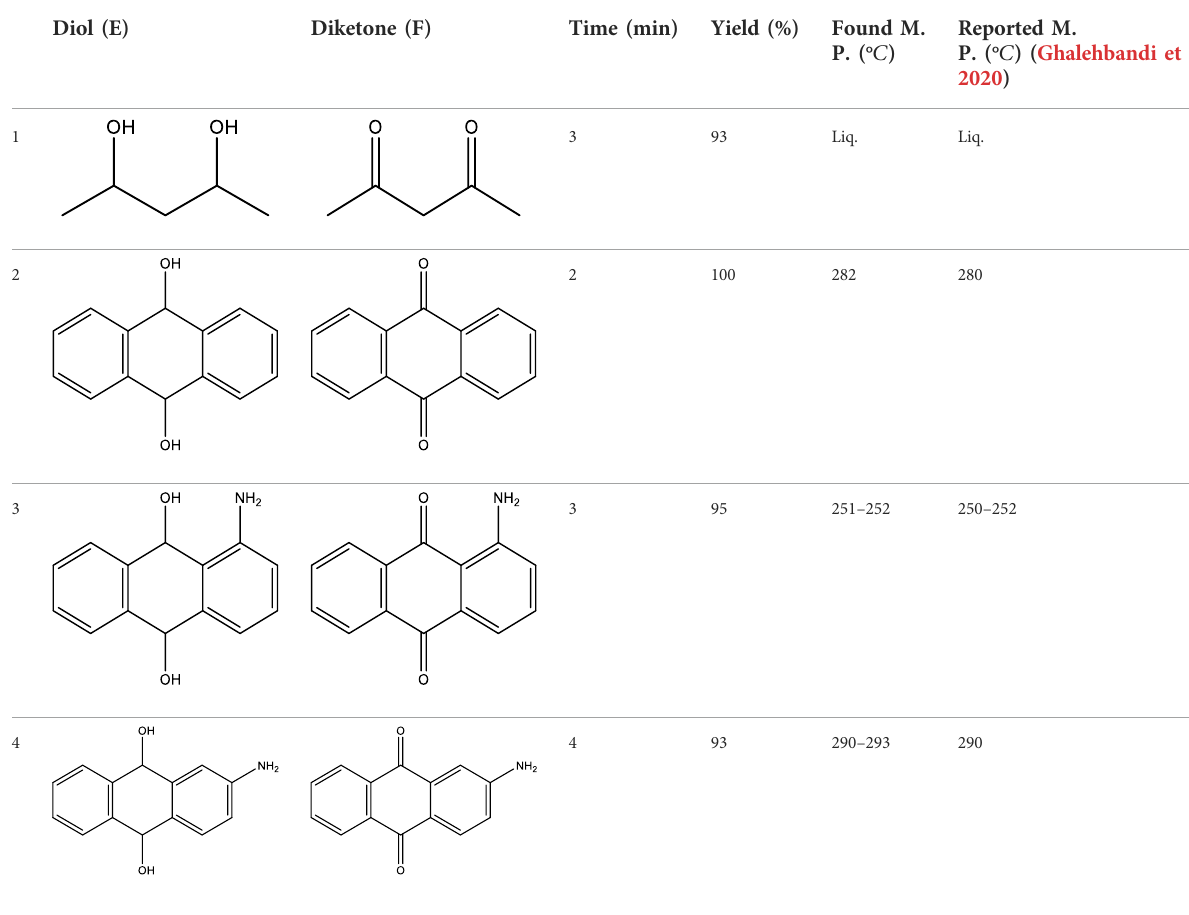
TABLE 4 Green oxidation of diol derivatives to diketone derivatives using CCPSF NPs under MW irradiation. Diol (E) Diketone (F) Time (min) Yield (%) Found M.